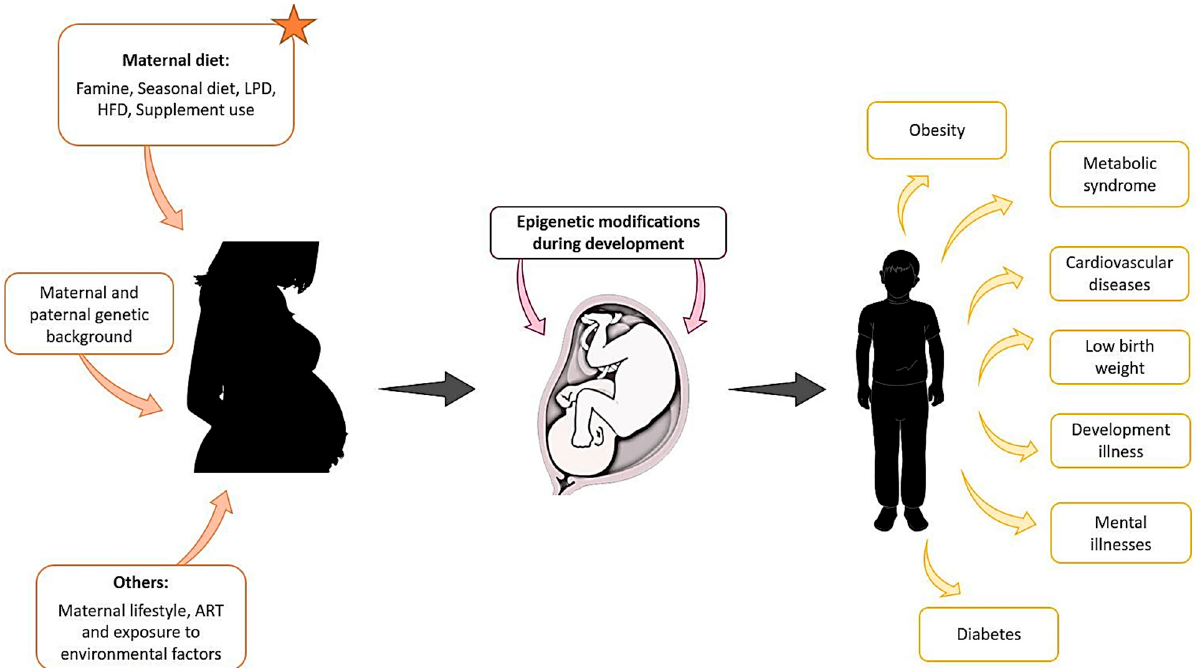
Figure 1. Maternal exposure to environmental factors, diet changes, genetic background, and other parameters such as lifestyle, can affect the development of the foetus from the first stages of pregnancy and compromise the health of the offspring later in life.